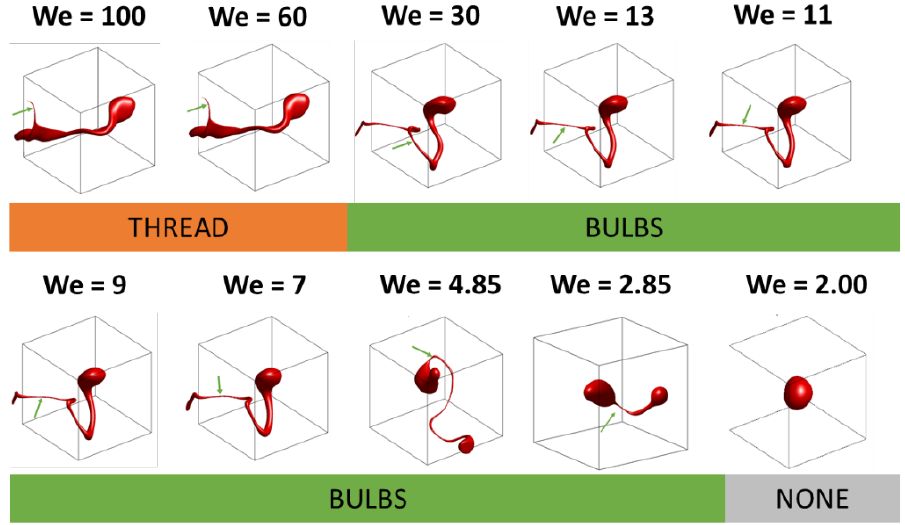
Figure 8. Morphology at initial breakup as a function of Weber number for a high viscosity drop ( μ D /μ C = 40). Green arrows show the point of initial detachment.